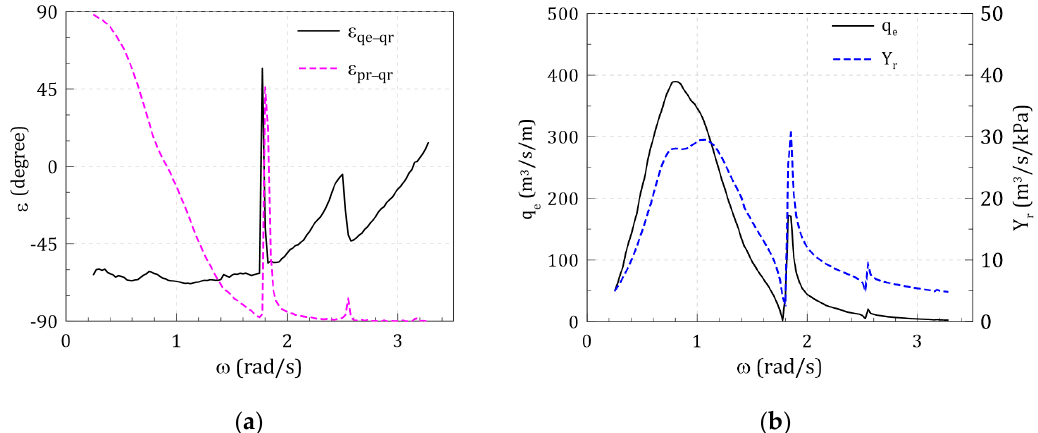
Figure 8. Phase difference and magnitude of OWC chamber responses under various frequency: ( a ) phase difference of decomposed pneumatic responses; ( b ) magnitude of excitation airflow coefficient ( q e ) and radiation admittance ( Y r ) under various excitation frequencies.